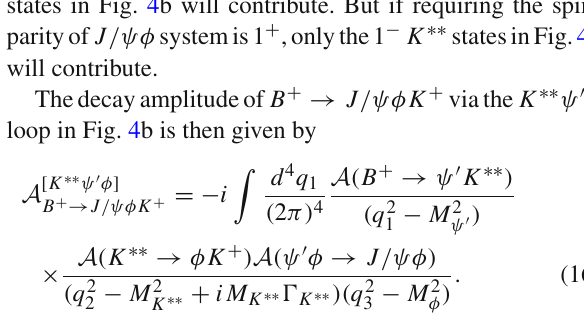
K ( 1911 ) (dashed line) given by LHCb [1], separately. For b : The mass and width of K ∗∗ with J P = 1 − are taken to be those of K ∗ ( 1410 ) (solid line), and K ∗ ( 1680 ) (dotted line) given by LHCb [1],